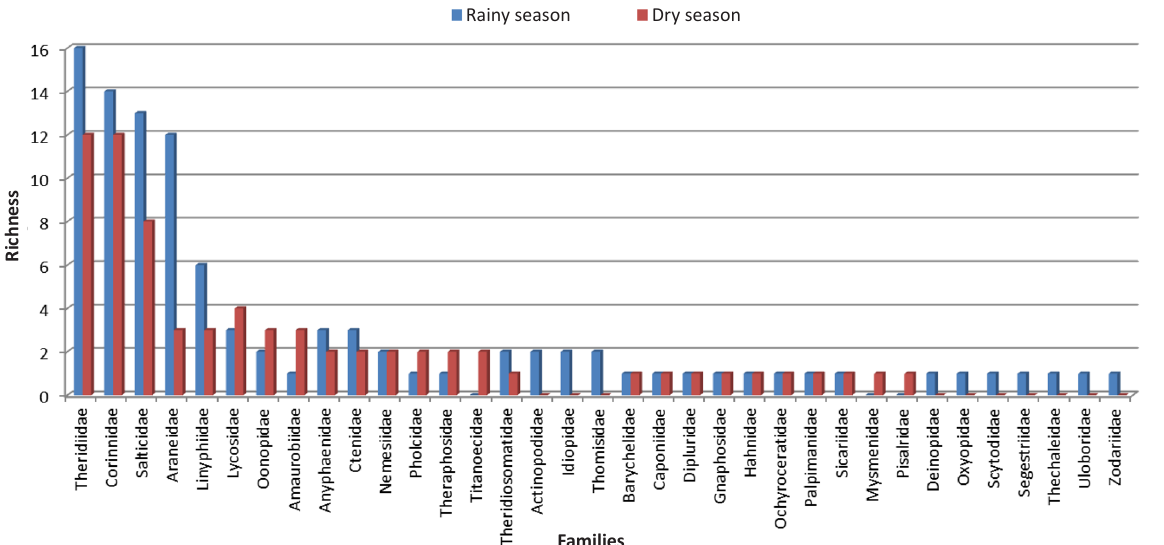
Figure 8. Species richness of spider families sampled in dry and rainy seasons in the Ecological Park Centennial Jatoba. (U=529;